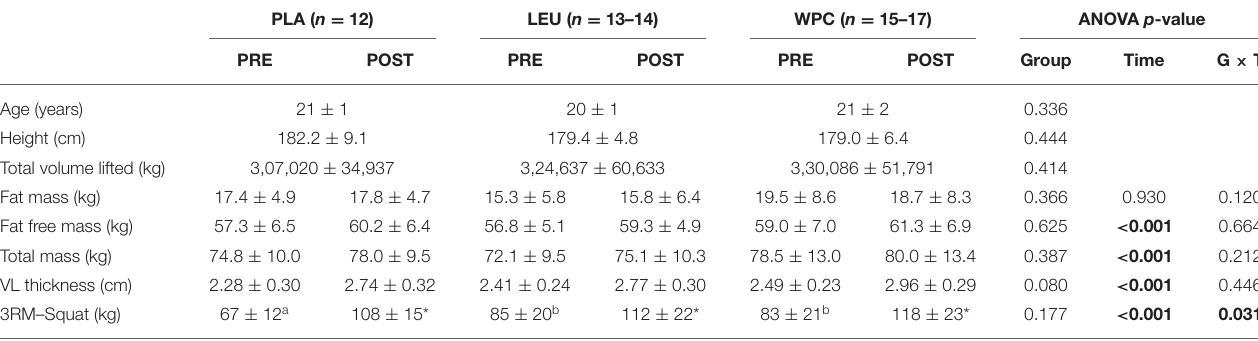
TABLE 2 | Participant characteristics prior to and following resistance